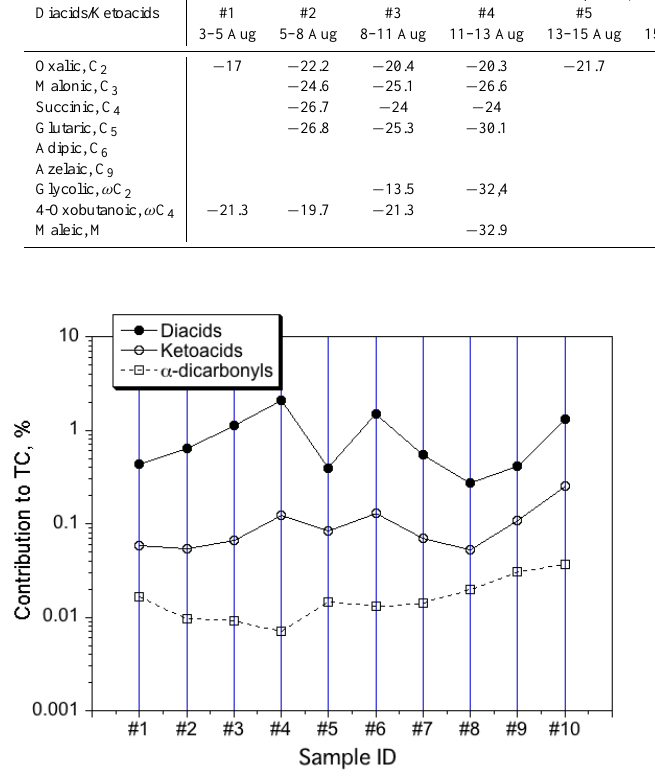
Fig. 6. Contributions of diacids, ketoacids and α -dicarbonyls to total carbon